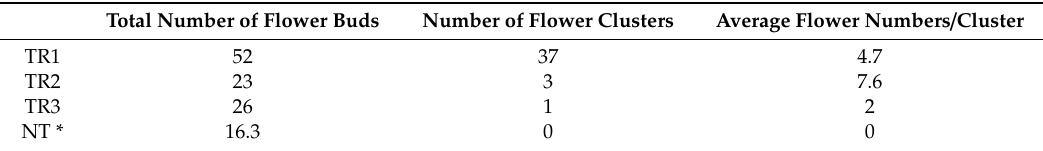
Table 1. Total number of flower buds, number of flower clusters, and average flower number for each cluster in transgenic and nontransgenic (NT) plants in November of 2017 in the greenhouse prior to their chill accumulation. * Average of three plants. Total Number of Flower Buds Number of Flower Clusters Average Flower Numbers/Cluster TR1 52 37 4.7 TR2 23 3 7.6 TR3 26 1 2 NT * 16.3 0 0